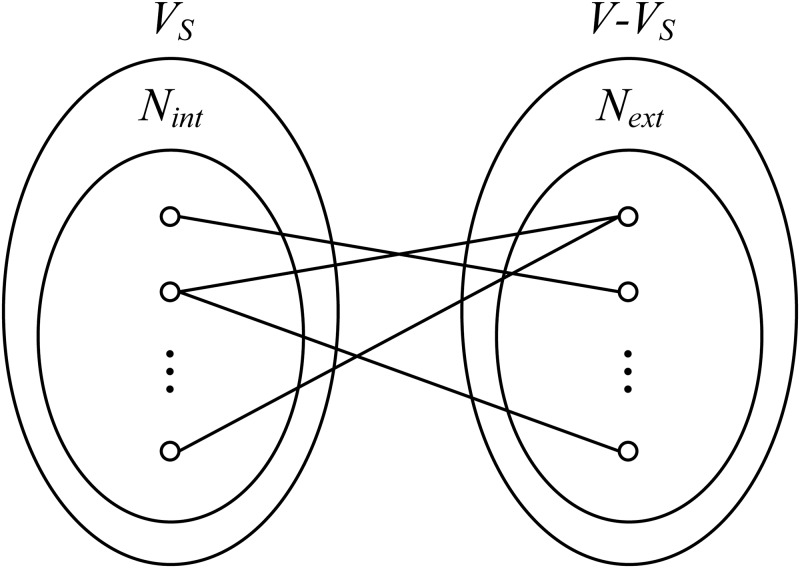
Illustrations of Next and Nint.